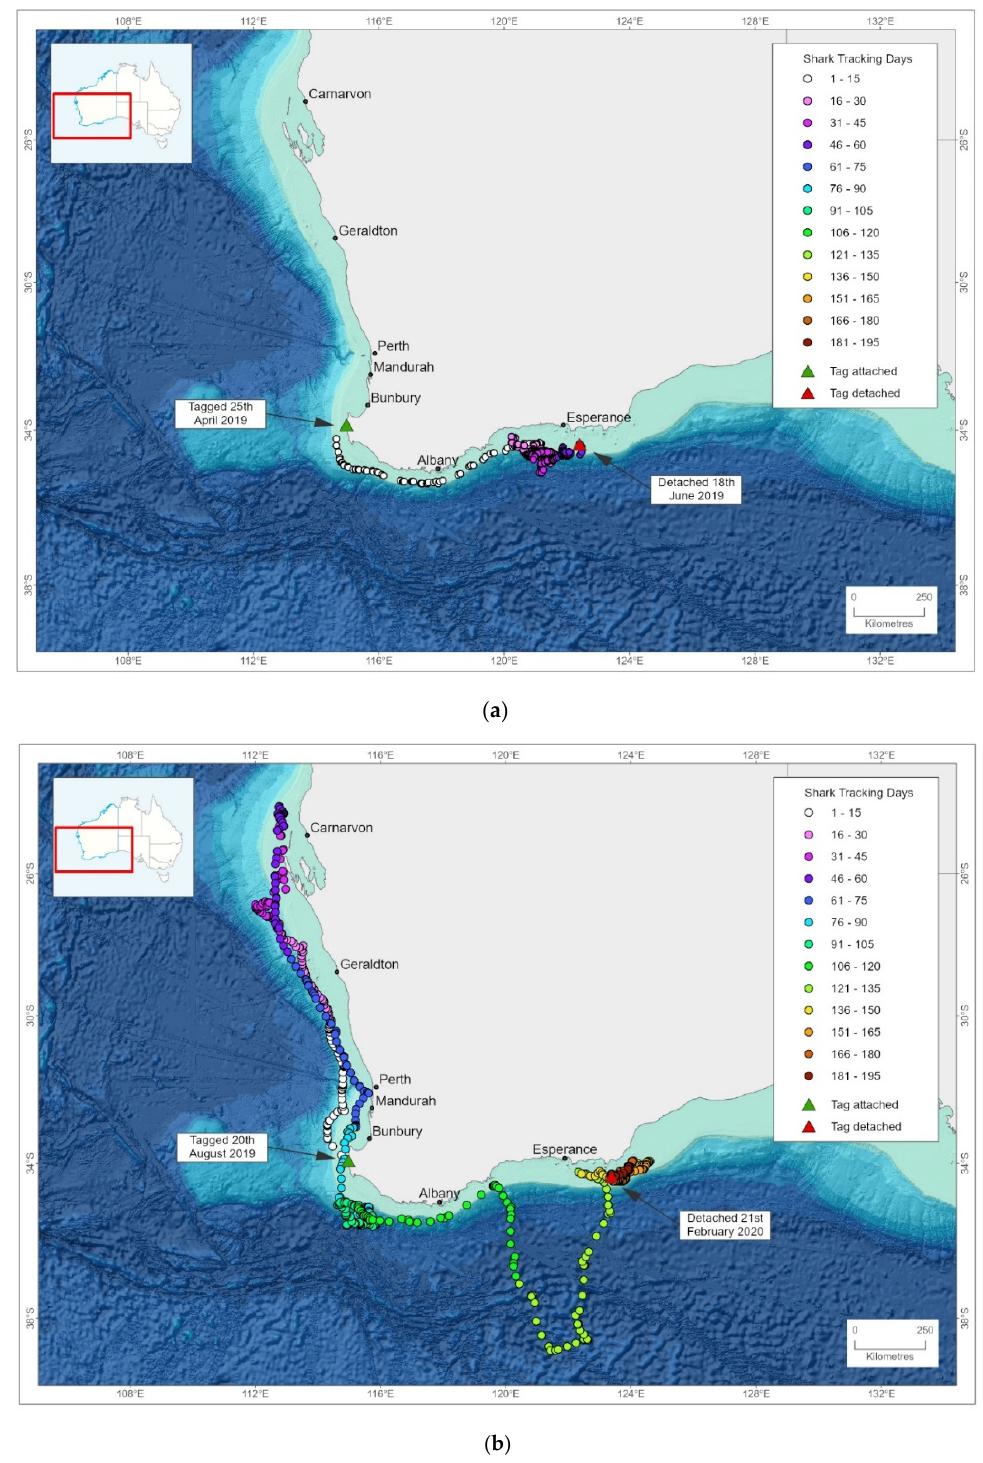
Figure 4. Estimated tracks of: ( a ) a 460 cm TL white shark caught on 25/4/19, tag duration of 54 days; and ( b ) a 330 cm TL white shark caught on 20/8/19, tag duration of 186 days. Tracks are based on model-estimated daily locations from PAT tags using GPE3.